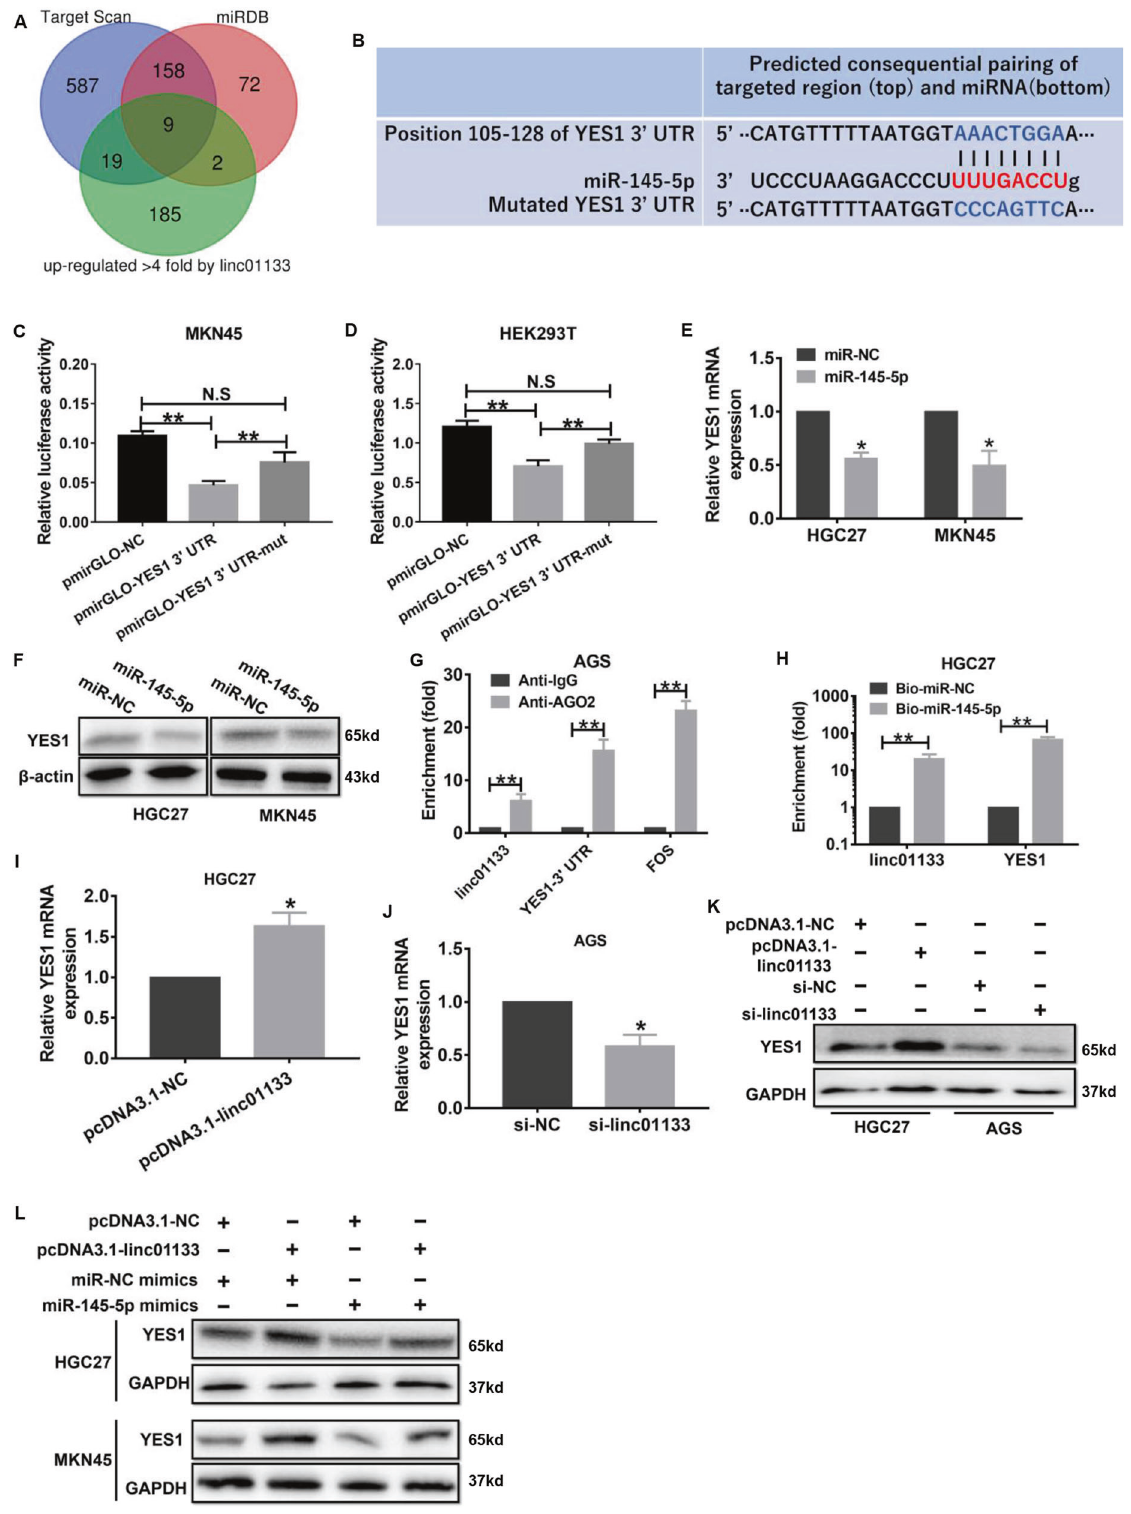
Fig. 5 YES1 is a common target of miR-145-5p and linc01133. A Venn diagram depicting 9 candidate common targets of miR-145-5p and linc01133. B The complementary sequence of YES1 3 ’ UTR with miR-145-5p seed sequence predicted by TargetScan and the mutated sequence. MiR-145-5p reduced the luciferase activity of pmirGLO-YES1 3 ’ UTR but not that with miR-145-5p binding site mutation in MKN45 ( C ) and HEK293 cells ( D ). MiR-145-5p inhibited YES1 expression in both mRNA ( E )and protein level ( F ). G YES1 3 ’ UTR is AGO2 bounded demonstrated by RIP assay. H YES1 could be pulled down by biotin-labeled miR-145-5p. Linc01133 overexpression in HGC27 cells or knocking- down in AGS cells increased or decreased the expression of YES1 both in mRNA ( I, J ) and protein level ( K ). L Linc01133 greatly attenuated miR- 145-5p induced YES1 down-regulation. Each experiment was performed in triplicates. Data are shown as mean ± SD, * P < 0.05, ** P <